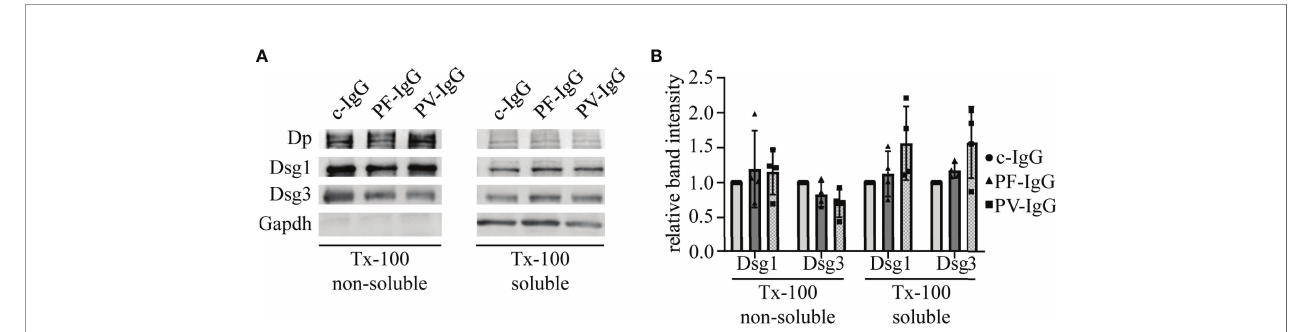
FIGURE 6 | Pemphigus IgG fractions do not induce changes in the distribution of Dsg1 and Dsg3 with respect to cytoskeletal anchorage. (A) Representative Western blot of Triton X-100 (Tx-100) fractionations of HaCaT cells incubated for 24 h with IgG fractions. (B) Corresponding quanti fi cation to (A) . Band intensities were normalized to GAPDH or desmoplakin (Dp) for non-cytoskeletal or cytoskeletal fractions, respectively. Resulting values were normalized to the corresponding c- IgG value. N=4; error bars represent standard